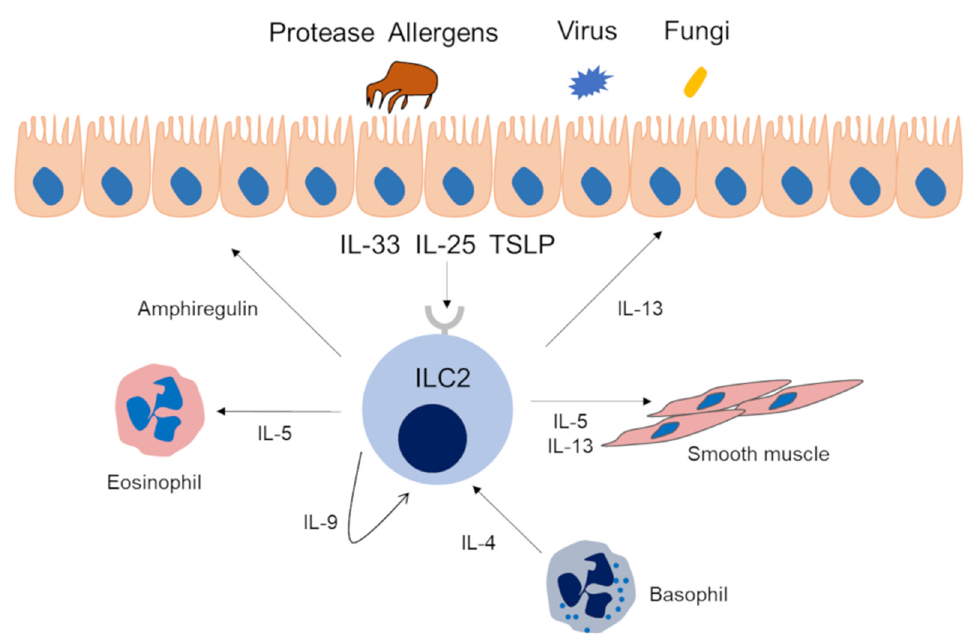
Figure 2. Type 2 immune response via ILC2s in asthma patients. Allergens with protease activity, fungi, and viruses promote the production of IL-25, IL-33, and thymic stromal lymphopoietin (TSLP) by airway epithelial cells. These cytokines activate ILC2s, and activated ILC2s produce IL-5, IL-9, IL-13, and amphiregulin. IL-5 and IL-13 have the same effect as that of the Th2 cell pathway. IL-9 prolongs ILC2 survival by autocrine actions. Amphiregulin is involved in tissue repair.